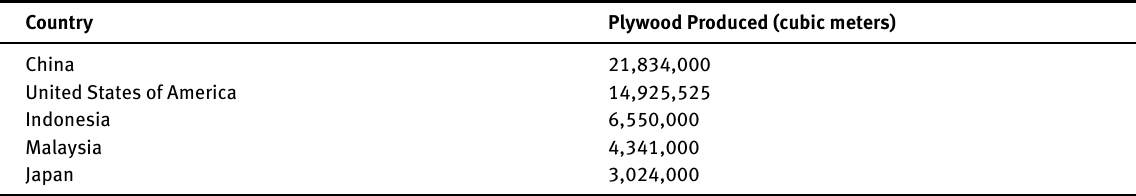
Table 3: Plywood Production from top 5 Plywood Producers